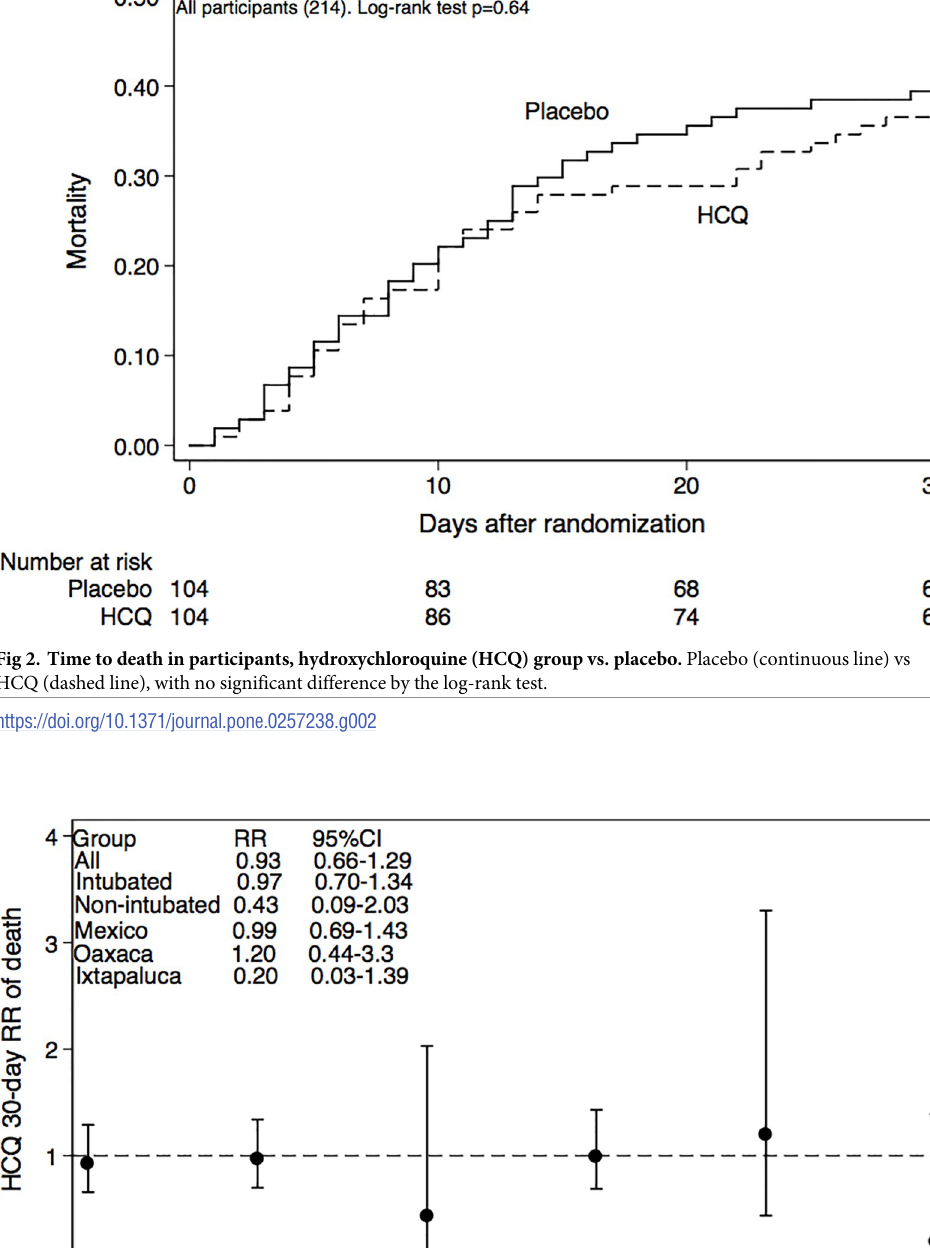
PLOS ONE | https://doi.org/10.1371/journal.pone.0257238 September 28,